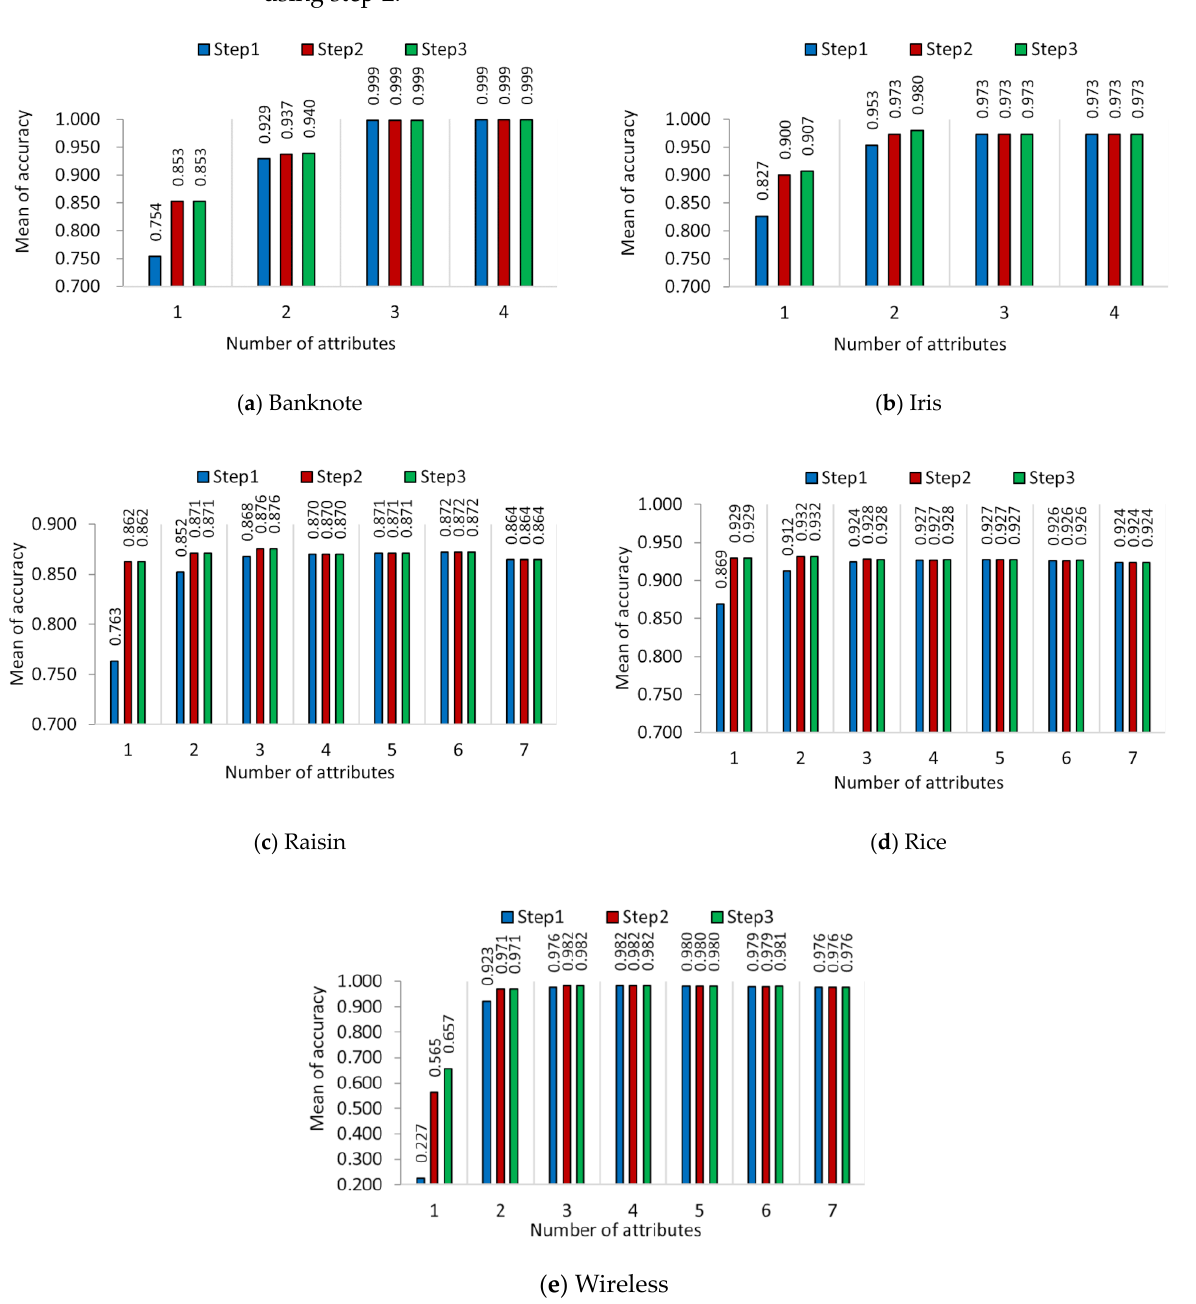
Figure 4. Comparison of DN-lower (step 1), DN-upper (step 2), and exceptional processing (step 3) at each attribute number for each UCI